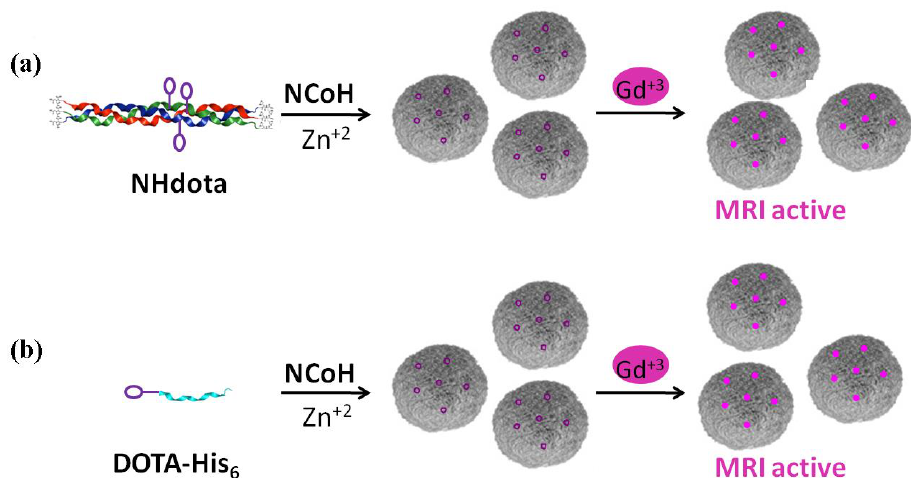
Figure 2. Strategies used for the generation of Gd(III)-loaded microflorettes with ( a ) NHdota and ( b ) DOTA-His 6 peptides.